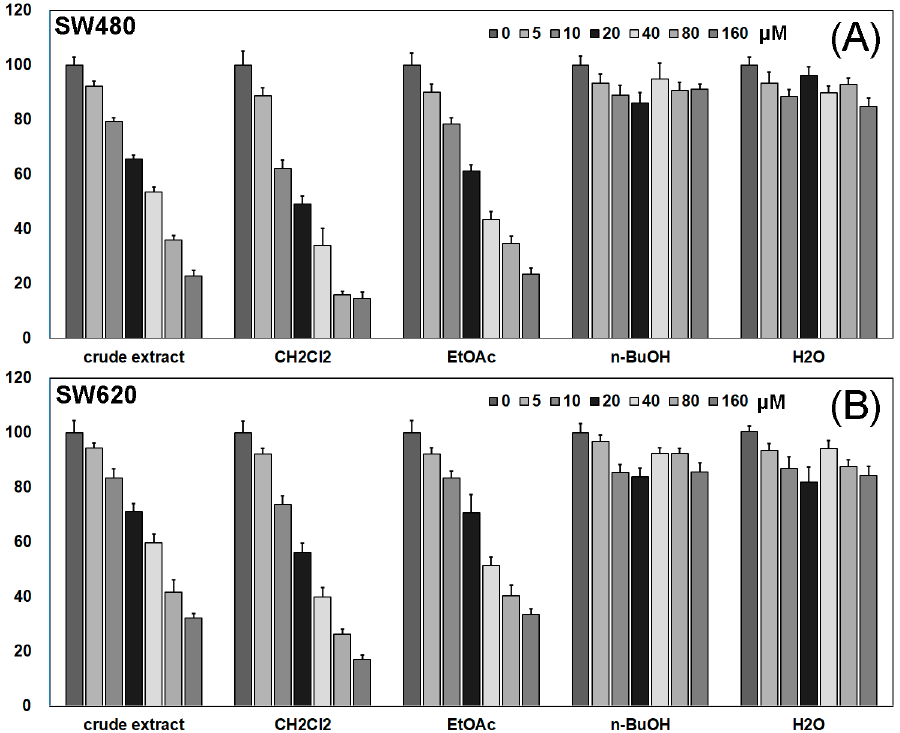
Figure 1. Cell viability as determined by CCK8 assay. ( A ) Different fractions of Pueraria lobata inhibit SW480 cell viability; ( B ) different fractions of Pueraria lobata inhibit SW620 cell